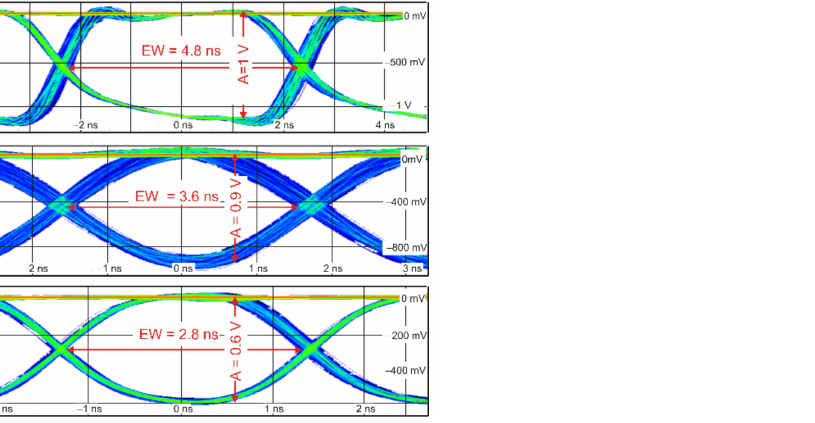
Figure 12. Eye diagrams for different modulation speeds: EW–eye width, A–“one” level